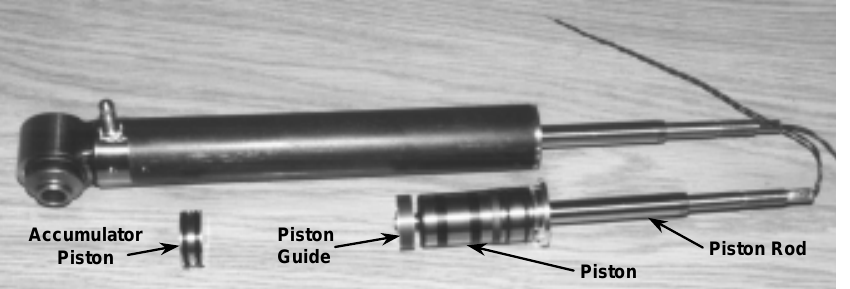
Fig. 4. MR damper and internal components.